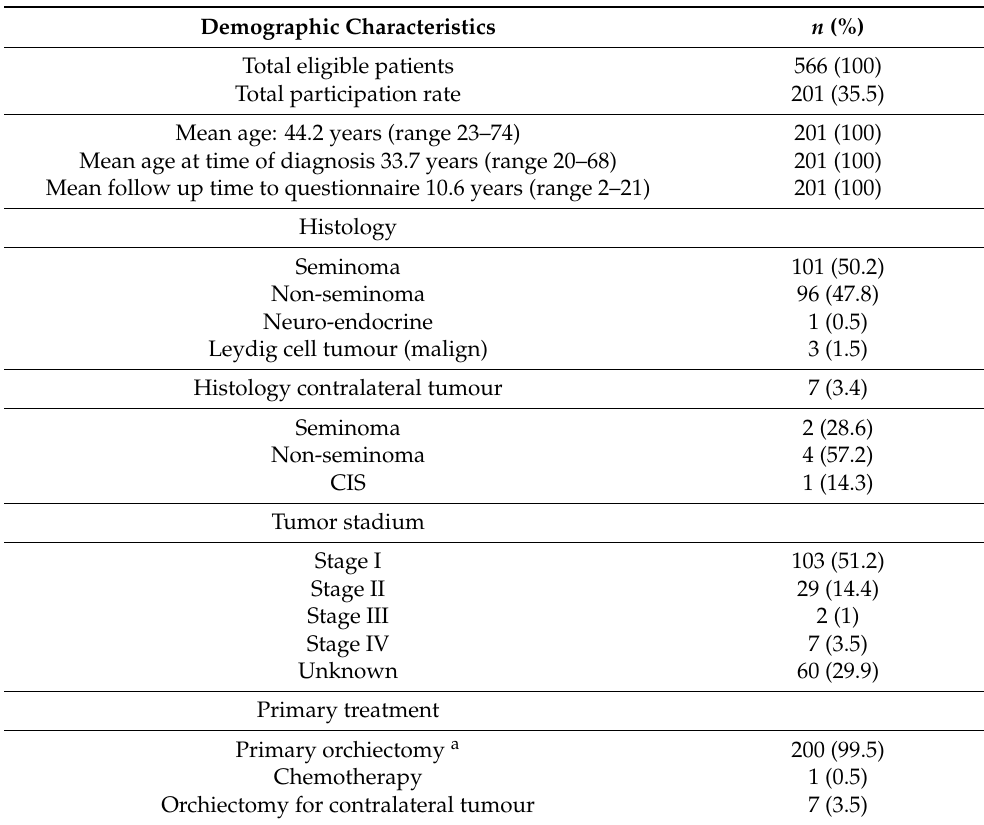
Table 1. Demographic